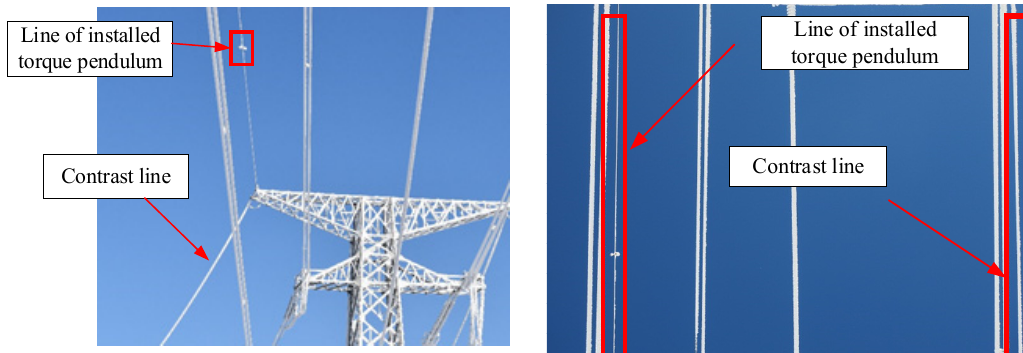
Figure 11. Natural icing contrast of overhead ground line.